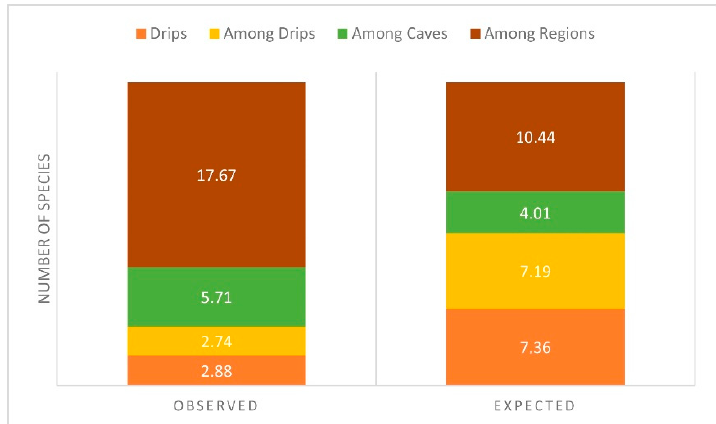
Figure 10. Relative contribution of within drip ( α -diversity), among drip, among cave, and among region diversity (all β -diversity) to the overall diversity of 30 epikarst copepod species, relative to random expectation. From Pipan et al. [65].